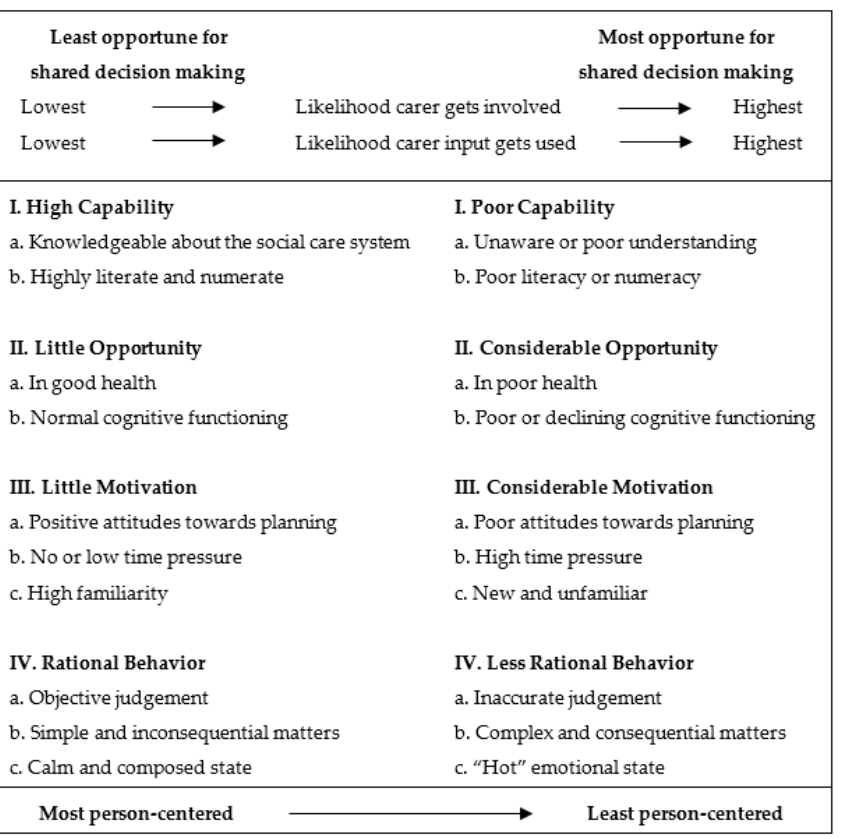
Figure 1. Impact model of shared decision-making in social care.